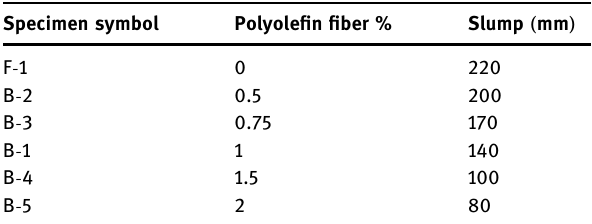
Table 8: Slump of concrete mixes with di ff erent contents of poly - ole fi n fi bers Specimen symbol